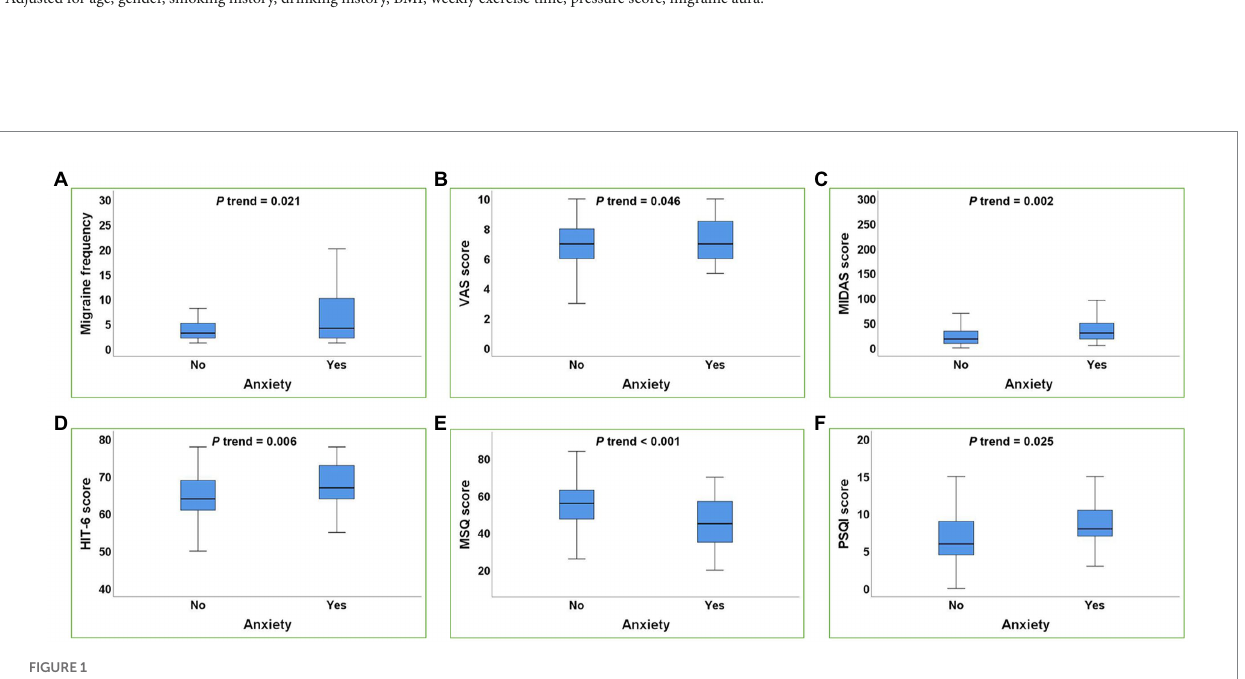
FIGURE 1 Box plot of the relationship between anxiety and migraine-related burdens. (A–F) : Anxiety was positively correlated with the migraine frequency (A) , VAS score (B) , MIDAS score (C) , HIT-6 score (D) , PSQI score (F) and negatively correlated with MSQ score (E) in migraine patients (all p trend<0.05). p trend value: Adjusted for age, gender, smoking history, drinking history, BMI, weekly exercise time, pressure score, migraine